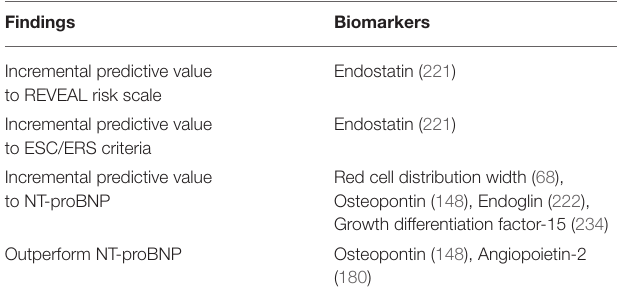
TABLE 2 | Major findings regarding novel biomarker performance against validated clinical tools.